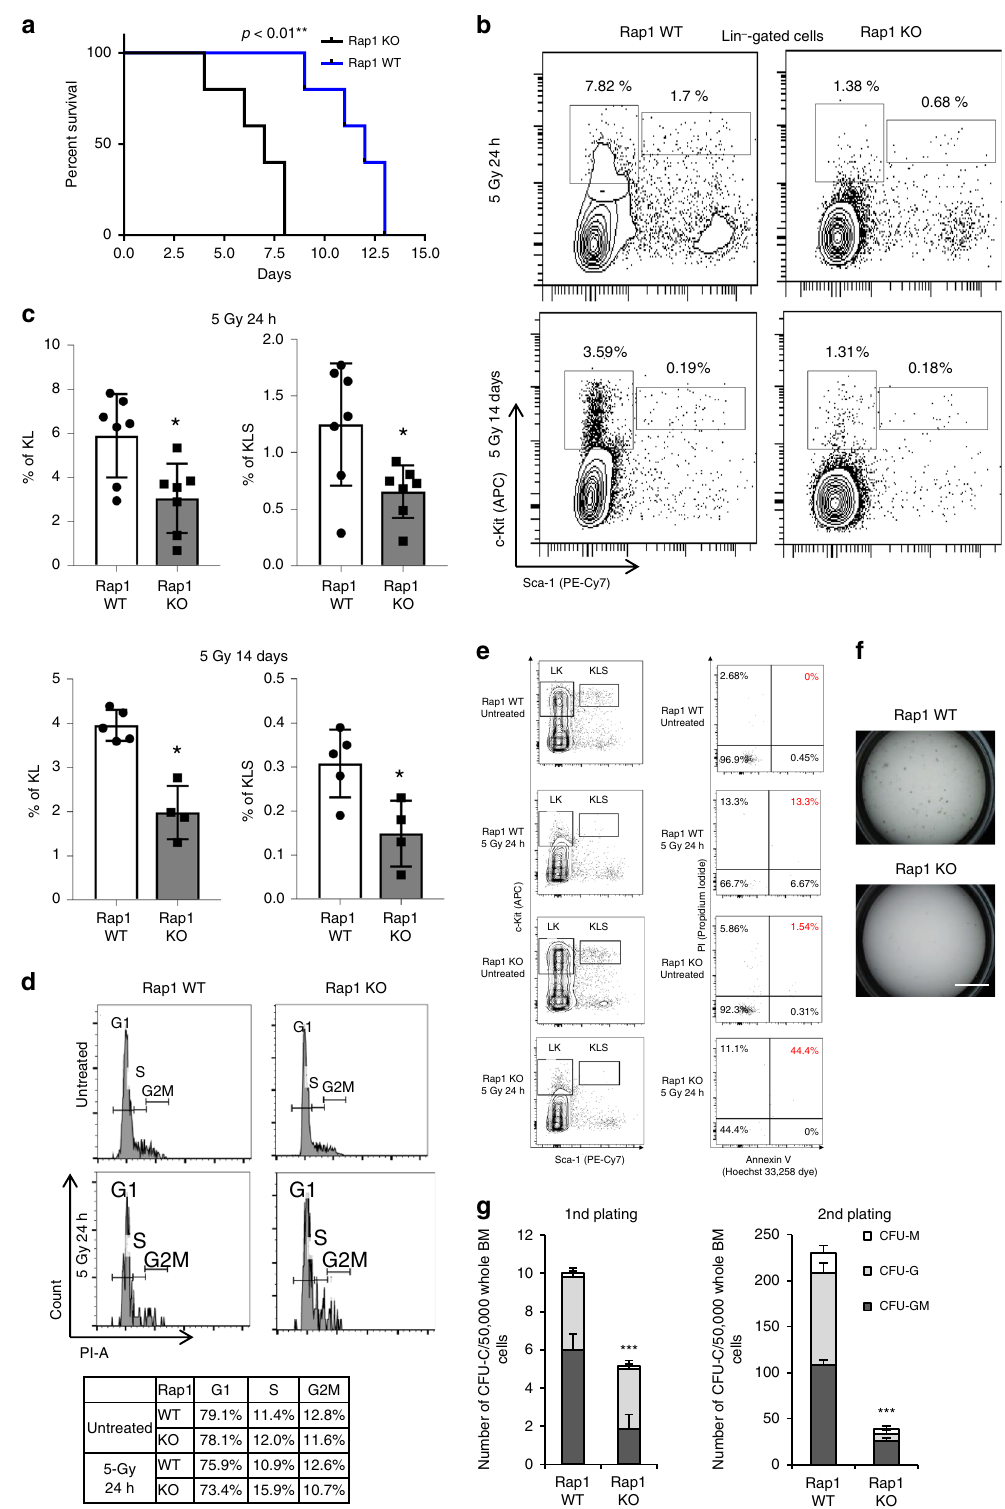
Rap1 null HSPCs accumulate more DNA damage after irra- diation . To determine if the observed difference in irradiation sensitivity in these mice is due to defects in DNA damage repair, we performed intracellular fl ow cytometry staining and immu- no fl uorescence analysis for phosphorylated H2AX ( γ -H2AX), a marker for DNA damage, on HSPCs from irradiated mice. NATURE COMMUNICATIONS| (2019) 10:5349